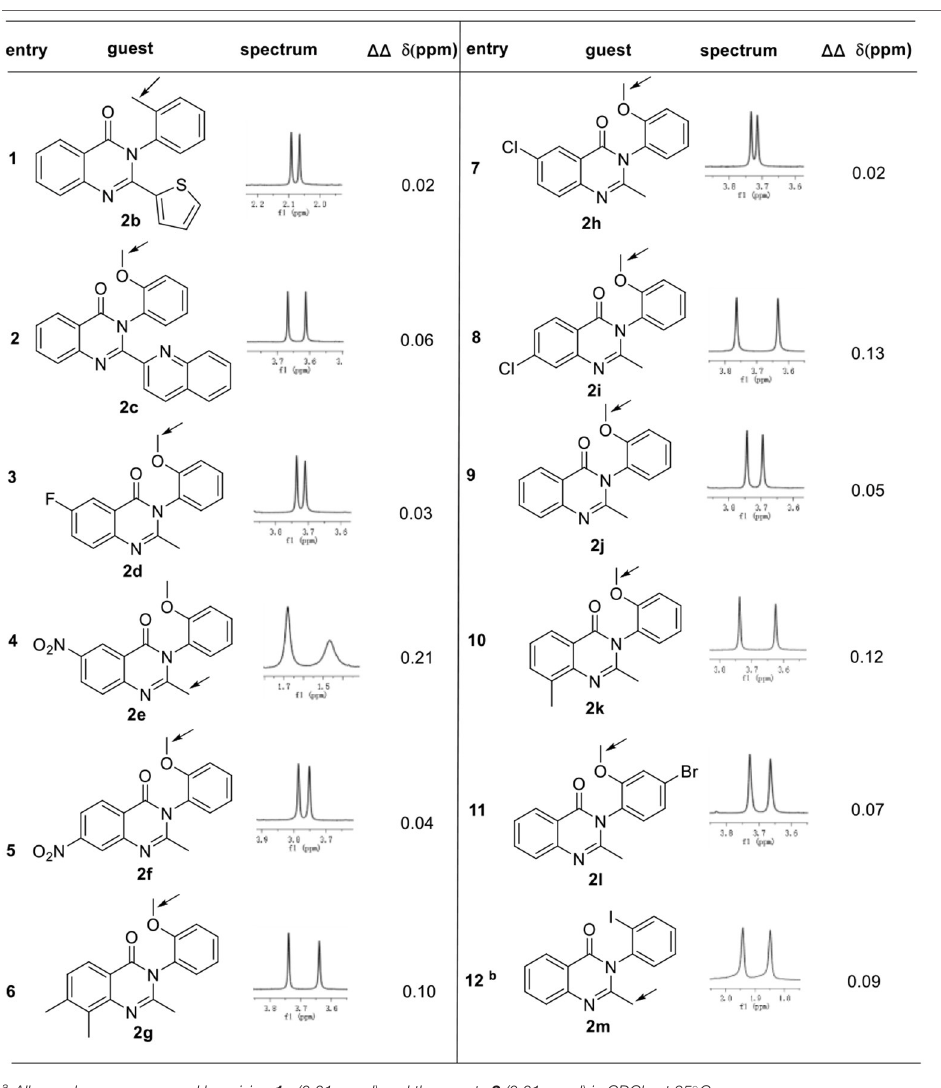
TABLE 2 | Differentiating the enantiomers of different racemic 3-arylquinazo-linones derivatives 2 in the presence of phosphoric acid 1a a .